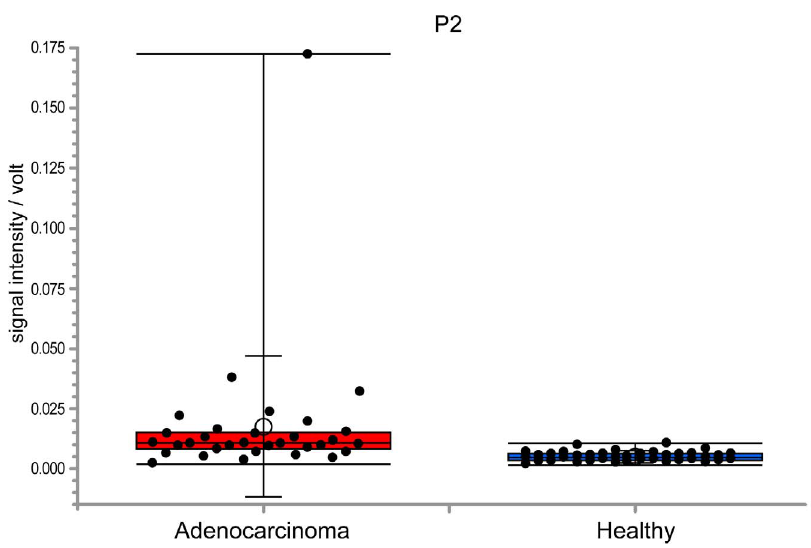
Fig. 3. Box-and-whisker plots of peak-2 between healthy and lung adenocarcinoma patients. Peak 2 was significantly higher in patients with lung cancer (p , 0.001). The box represents the 25th and 75th percentiles, the whiskers represent the range, and the lined box represents the median, whereas circles represent the mean. Lung adenocarcinoma patients revealed a significantly higher n-Dodecane VOC peak than healthy volunteers and the n-Dodecane VOC peak could separate values with a sensitivity of 81.3% and a specificity of 89.7%.